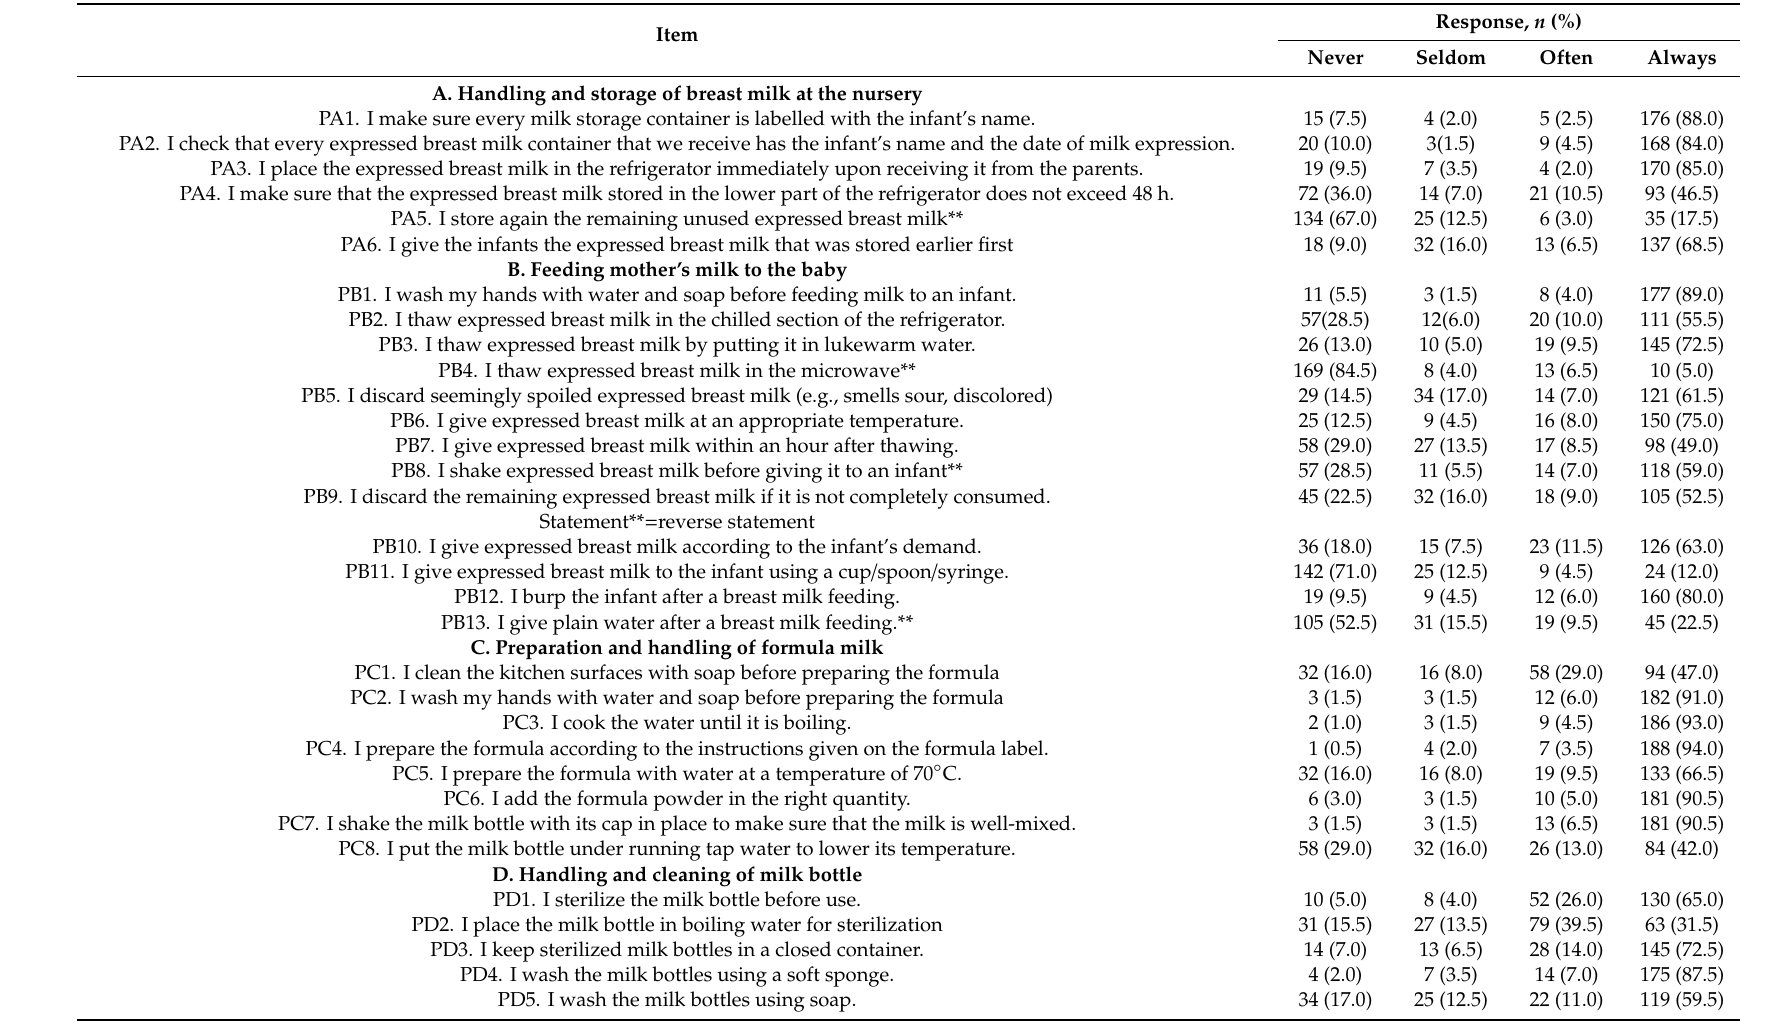
Response, n (%) Never Seldom Often Always